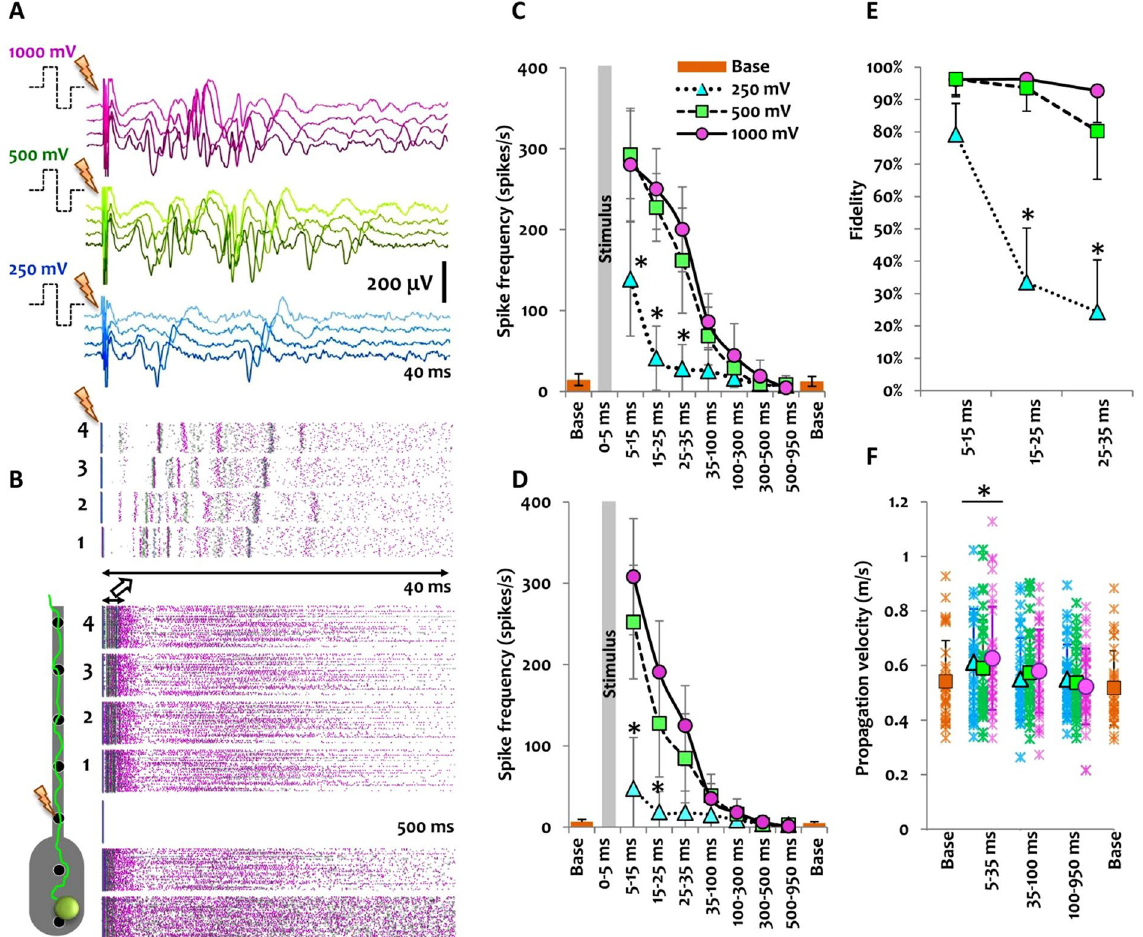
Figure 7. Local axonal stimulation in a microchannel and its effect on the signal propagation velocity. ( A ) From top to bottom: 40 ms post-stimulus responses to a symmetric biphasic (1 Hz; ± 200 µ s: first positive ( + ) phase (100 µ s duration) followed by negative ( − ) phase (100 µ s duration)) stimulus with 1,000 mV (red), 500 mV (green) or 250 mV (blue) amplitude. In all cases, the stimulation pulse was applied through the proximal electrode and the direct effect or evoked responses were recorded by four subsequent electrodes from the same axonal branch as shown in B. Darker colors indicate closer proximity of the recording electrode to the stimulation site. (B) Overlaid peri-stimulus raster plots for 100 biphasic stimulation pulses of 1,000 mV (red), 500 mV (green) or 250 mV (blue) amplitude. Lower panel: 500 ms peri-stimulus raster plot for four subsequent microchannel electrodes and two corresponding reservoir electrodes. The upper panel illustrates the first 40 ms of the same raster plot on four subsequent microchannel electrodes with reliable and densely packed responses over the first 15 ms, which also matches the exemplary recording profiles in A. In each raster plot, the responses to the 100 stimuli were arranged in 100 rows from top to bottom. ( C) Axonal activity response to stimuli with different amplitudes during a 1 s peri-stimulus period was defined as the mean number of spikes per second for specific time-widows. The mean activity in each time-window was averaged across 12 experiments (for 4 cultures and 12 microchannels). In each experiment, three different stimulation amplitudes (180 trials each; 1 Hz) were applied to the same electrode. Baseline activity recorded from the same set of electrodes before and after each stimulation experiment. Data are represented as mean ± StDev. * p < 0.05 vs . baseline activity (Base) in the same microchannel. ( D) Activity recorded from the corresponding reservoir module (one electrode pair in each reservoir) for the same experiments as in C. * p < 0.05 vs . baseline activity in the reservoir module. (E) The response reliability to certain stimulation pulse amplitudes was counted in three peri-stimulus time windows over 180 trials and the percentage of successful trials (at least one spike per time–window) was calculated. Individual points represent the average reliability percentage across 12 stimulation experiments for each stimulation pulse amplitude. * p < 0.05 vs . the response fidelity to 1,000 mV stimuli in the same time- window. ( F) Propagation velocity in electrically stimulated axons for different pulse amplitudes (pink: 1,000 mV, blue: 500 mV, green: 250 mV, orange: baseline). Propagating spikes in different peri-stimulus time-windows were extracted and the average velocity was calculated across 12 experiments (mean ± StDev). In each time window, 36 points represent the average signal velocity at three axonal segments between electrodes 1 to 4 in B. * p < 0.05 vs . velocity at